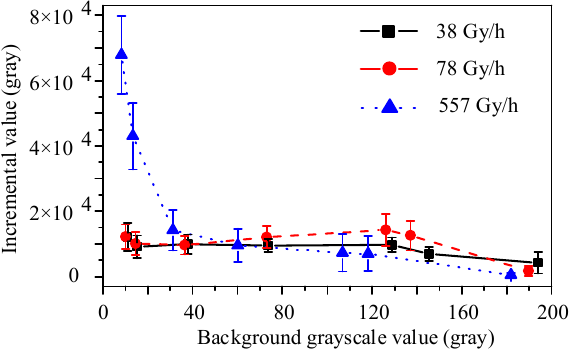
Figure 7. Mean grayscale incremental value of 4T-APS with different grayscale backgrounds at the irradiation dose rates of 38, 78, and 557 Gy/h.